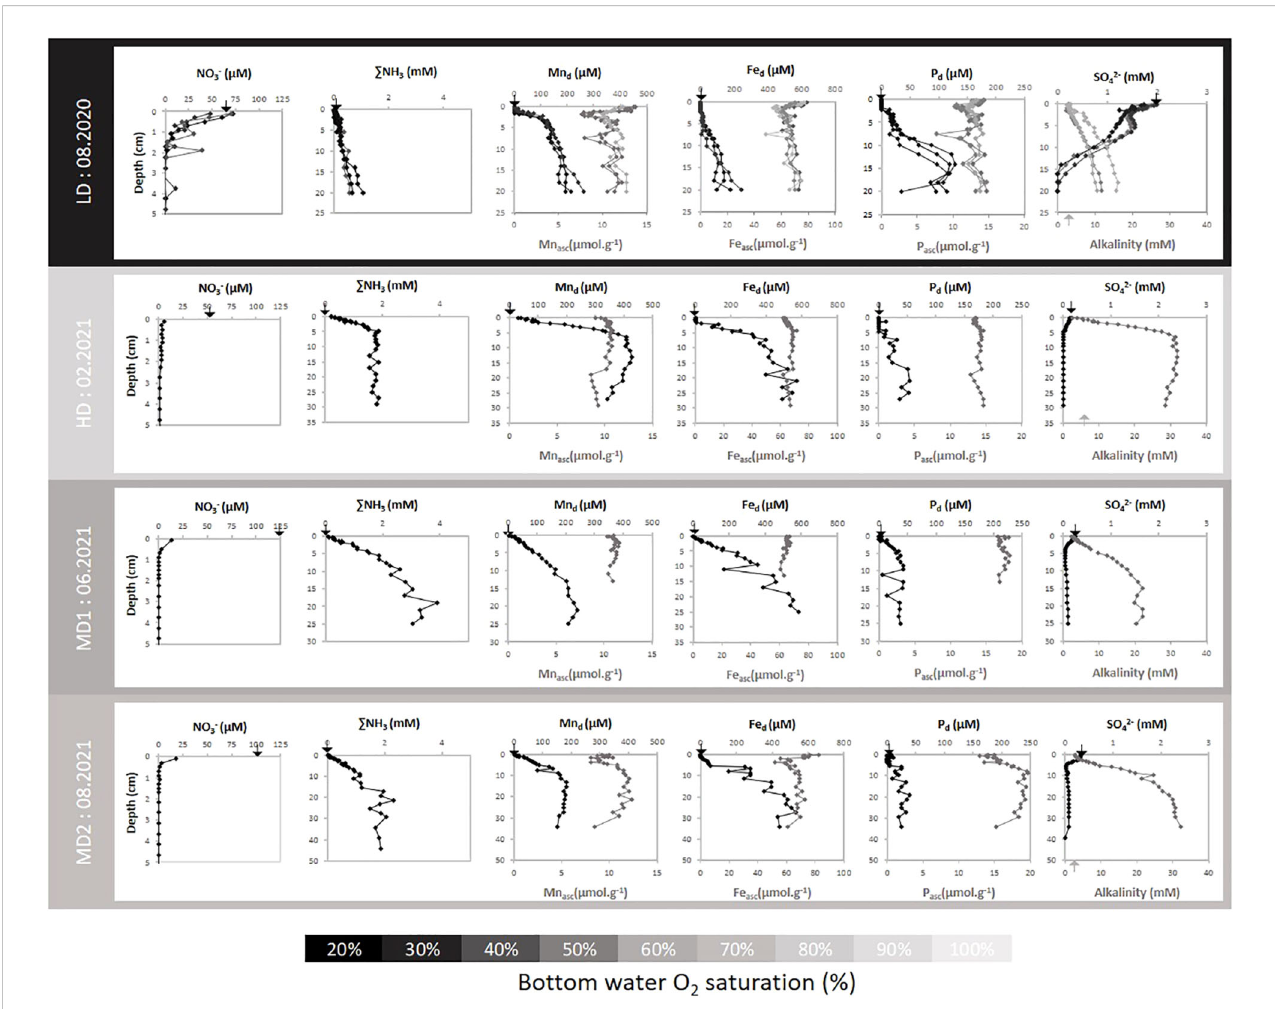
FIGURE 6 Porewater pro fi les of NO 3- , ∑ NH 3 , dissolved Mn (Mn d ), dissolved Fe (Fe d ), dissolved P (P d ), and SO 42- concentrations with depth in the sediment (black lines). Ascorbate extractible iron (Fe asc ), manganese (Mn asc ), and phosphorus (P asc ) concentration and alkalinity are also plotted in gray. Black triangles at 0 depth indicate overlying water